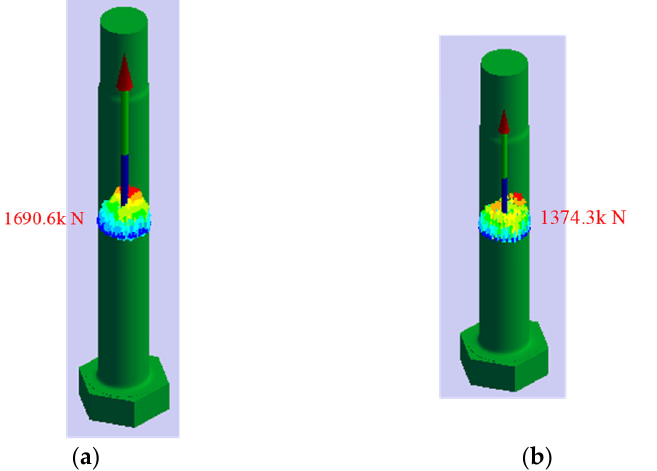
Figure 13. Resultant force of bolt: ( a ) existing configuration and ( b ) new design.